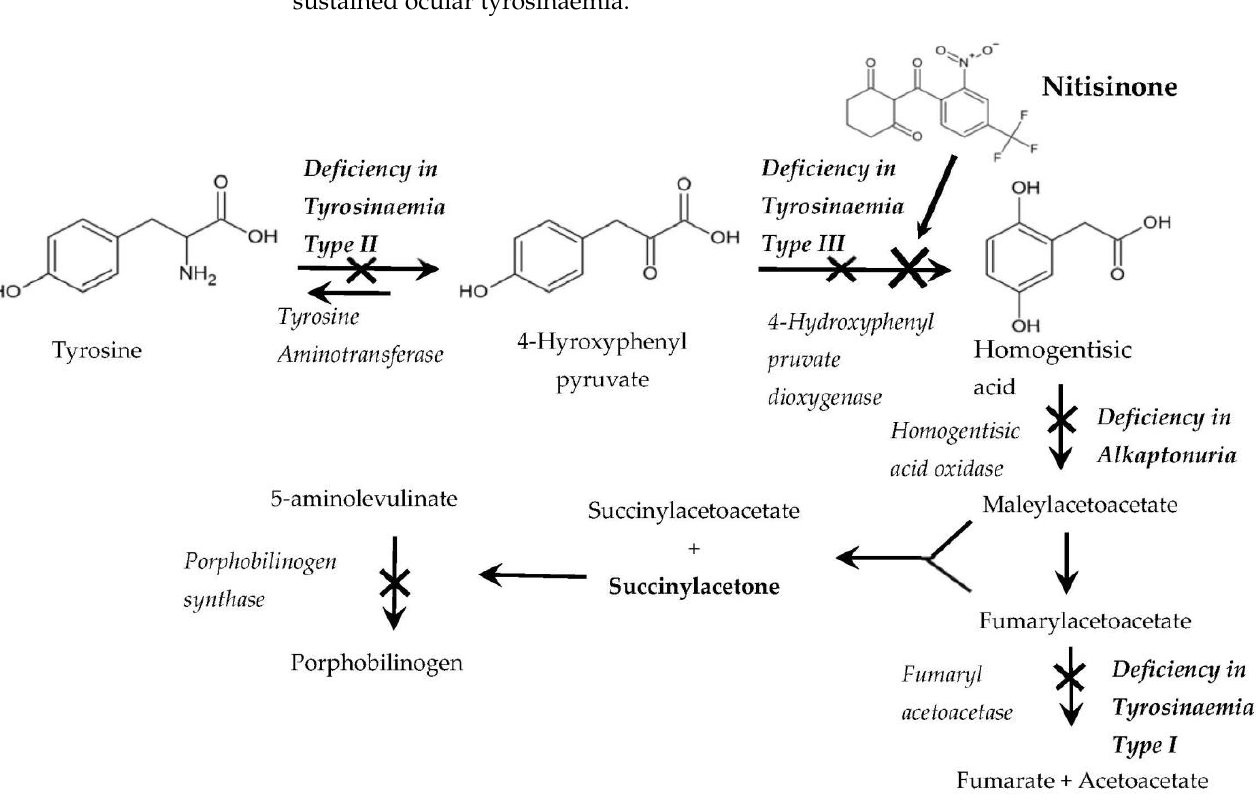
Figure 1. The metabolic pathway for tyrosine catabolism in humans and experimental animals, showing the enzymes involved, the known sites of inborn errors in metabolism and the site of action of the drug Nitisinone used to treat tyrosinaemia type 1 and alkaptonuria.